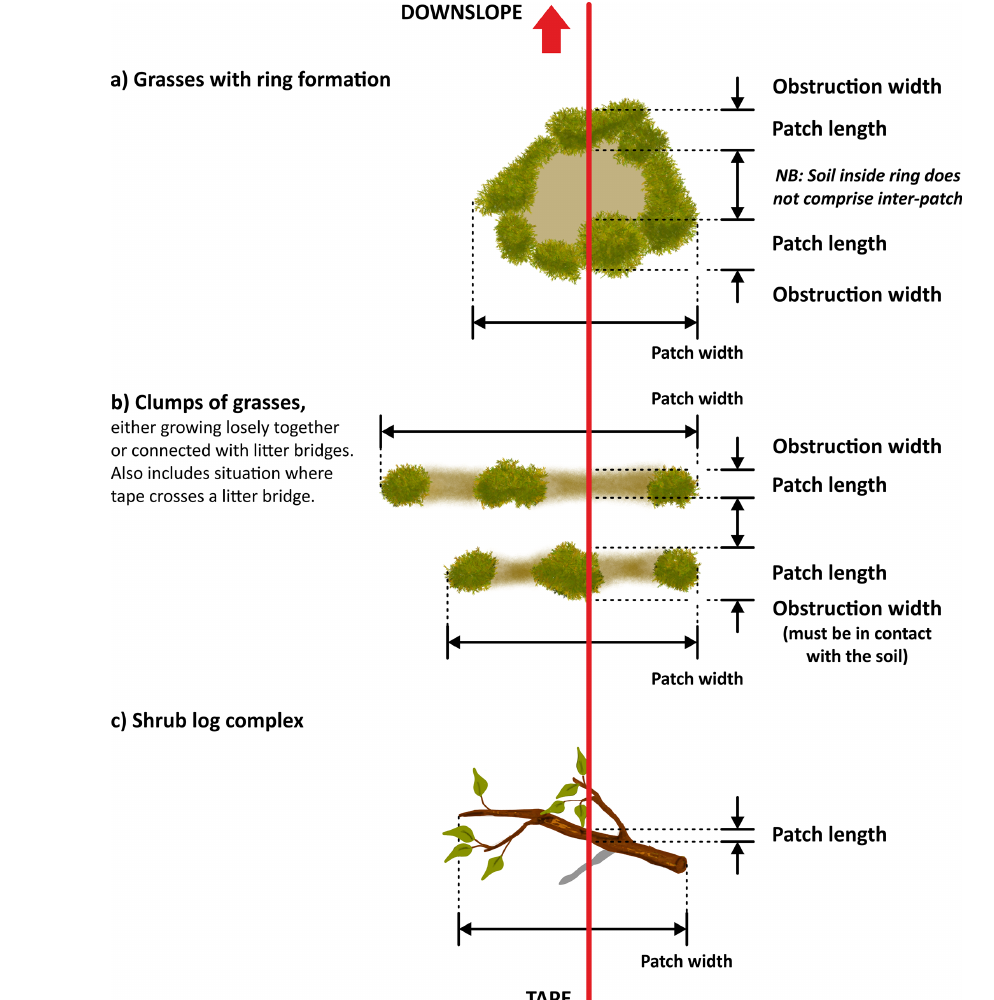
Figure 7. A diagrammatic illustration showing how to measure the length (along the transect) and the width of patches (right angles to the transect). Redrawn from Tongway and Hindley